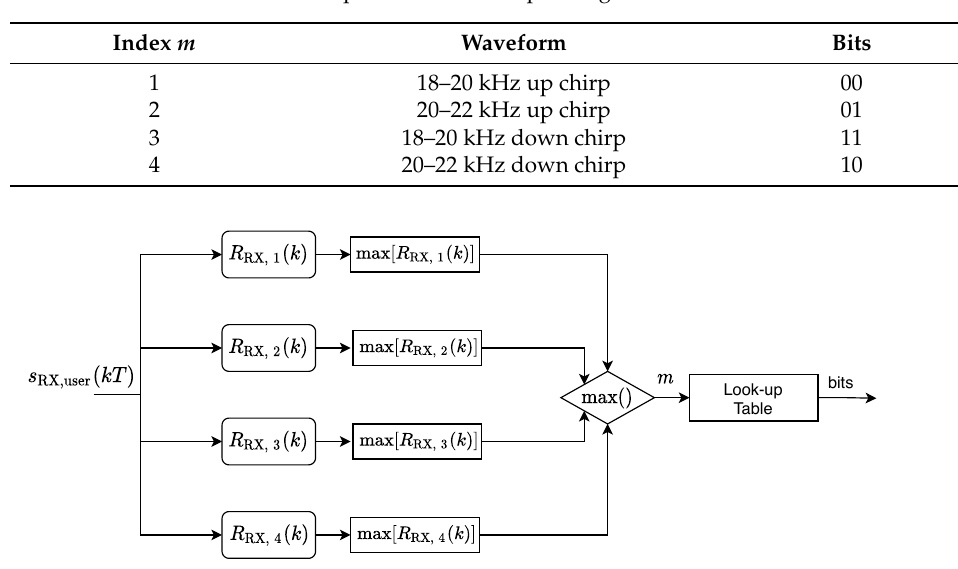
Table 1. Association between chirp index and corresponding information bits.